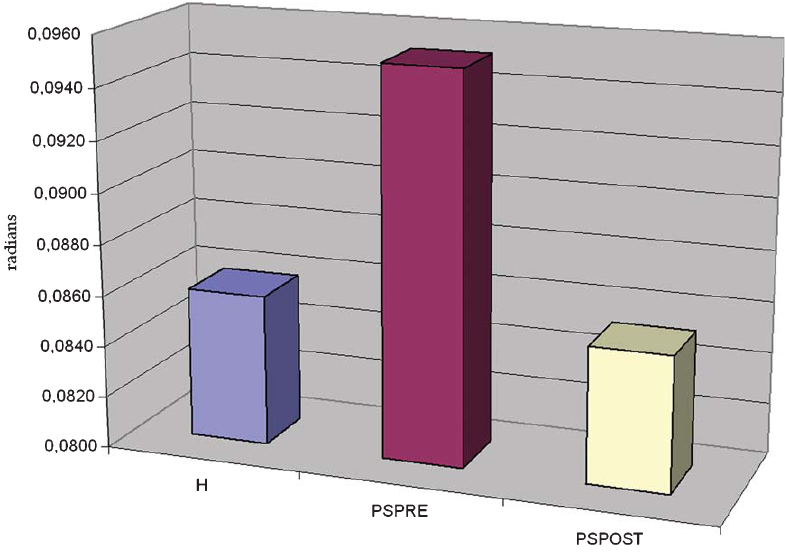
Fig. 8. Group values of parameter Max ( (cid:1) F ) for direction N t , in P H , P PSPRE and P PSPOST .